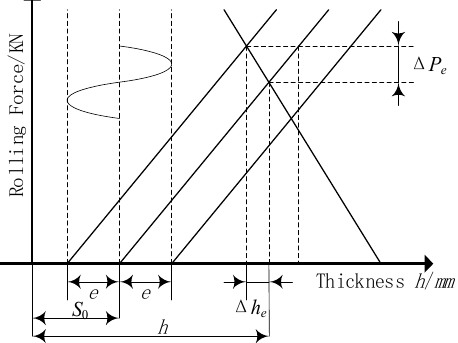
Figure 2. Influences of roll eccentricity on the thickness.